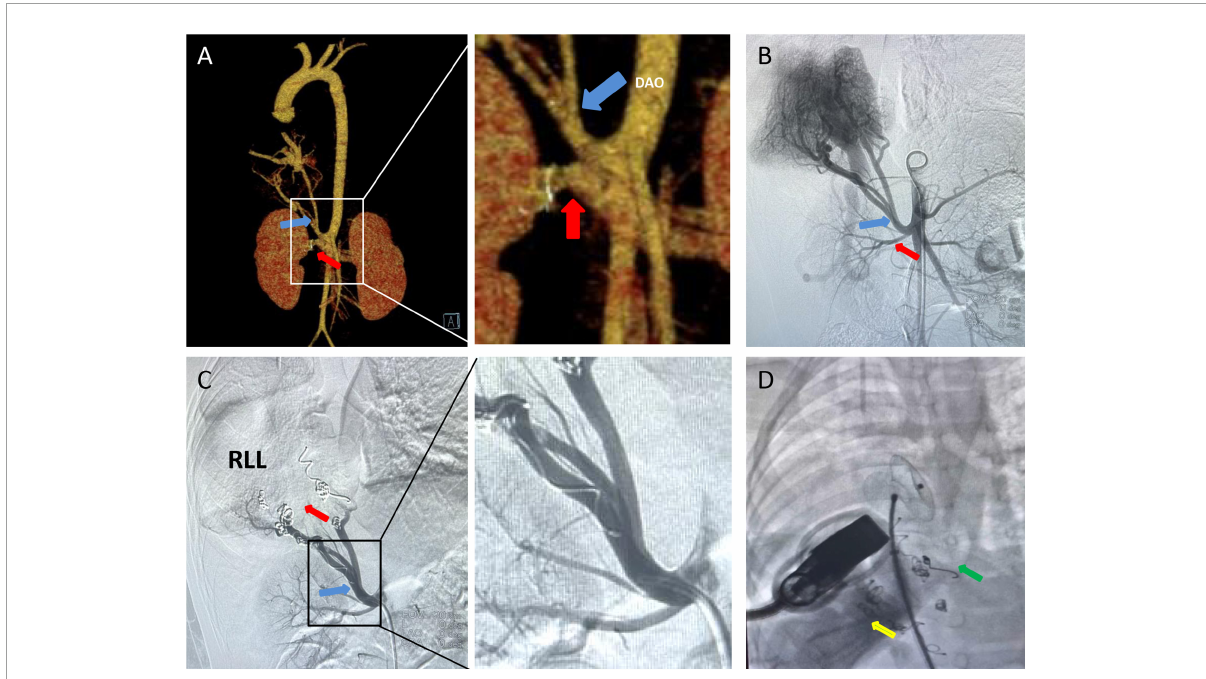
FIGURE3 CT 3D reconstruction and Aortic DSA: (A,B) A isolates the pulmonary supplying artery (blue arrow) and the renal artery (red arrow) to the abdominal aorta, and isolates the pulmonary supplying artery by approximately 4 mm. (C) Nine platinum coils were placed in the isolated pulmonary supplying artery (blue arrow), and no contrast agent entered the distal end of the infarct (red arrow). (D) Placement of atrial septal defect occluder (green arrow) under co-guided echocardiography (yellow arrow) and DSA. DAO, decending aorta; RLL, right lower lobe.